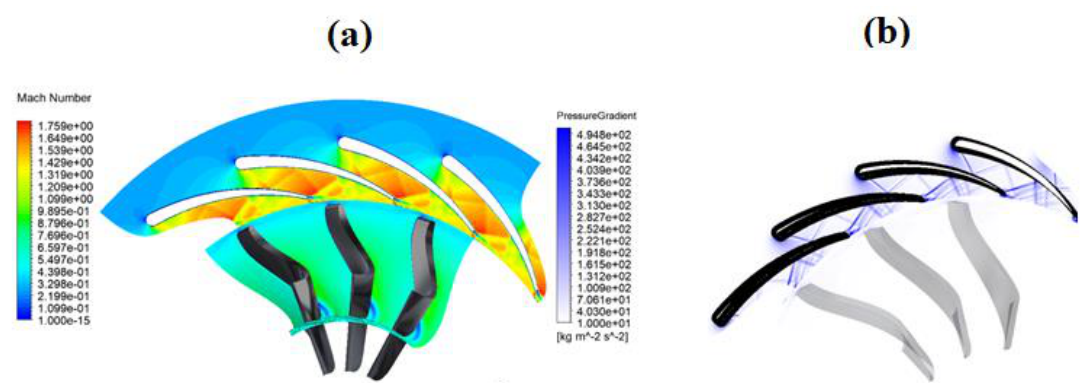
Figure 19. Mach number distribution ( a ) and pressure gradient ( b ) at design point (N = 40,000 rpm, PR = 6.9).